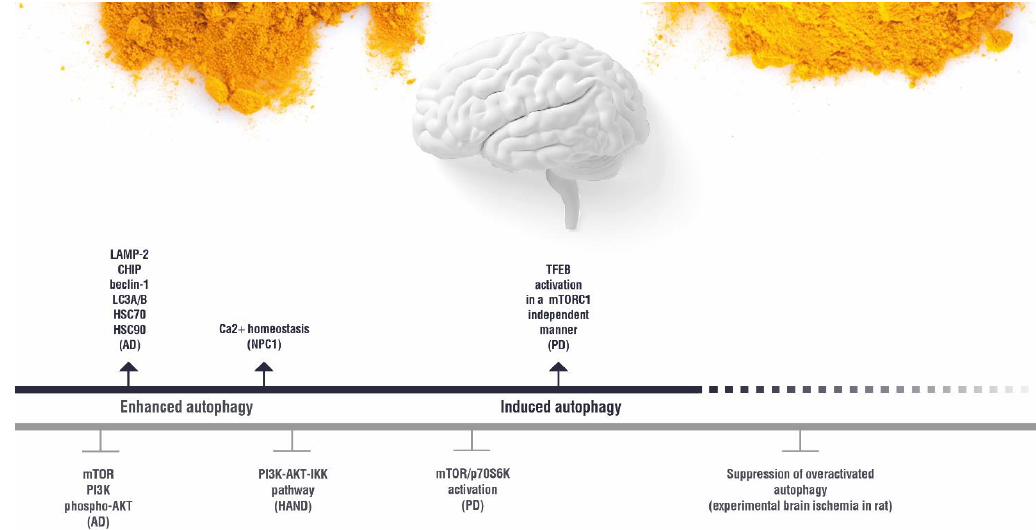
Figure 3. Overview of curcumin e ff ects on the autophagy pathways in neurological diseases. Biological e ff ect of curcumin on the molecules involved in the autophagy regulation in the neurological diseases discussed in the present review. (induction); (inhibition). AD: Alzheimer’s disease; HAND: HIV-induced neurocognitive disorder; PD: Parkinson’s disease; NPC1: Niemann Pick